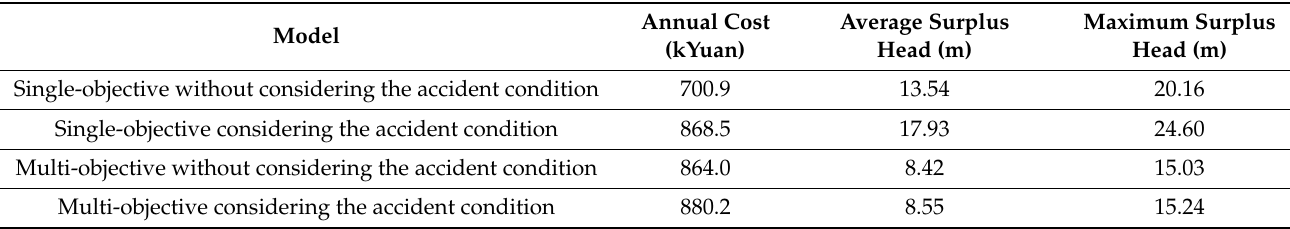
Table 3. Comparison of economy and reliability of optimization results of a multi pump station water distribution